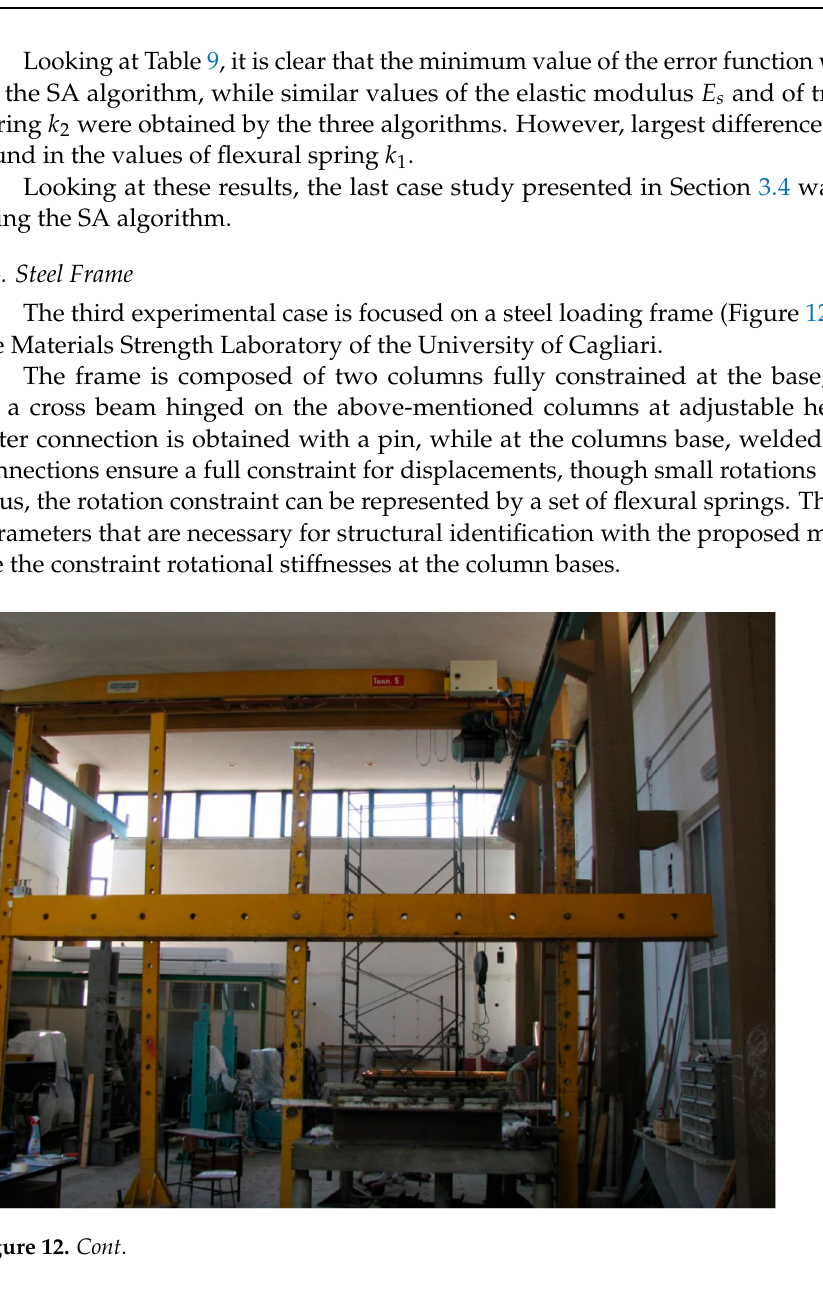
Table 9. Performance of different optimization algorithms for the cantilever beam case.